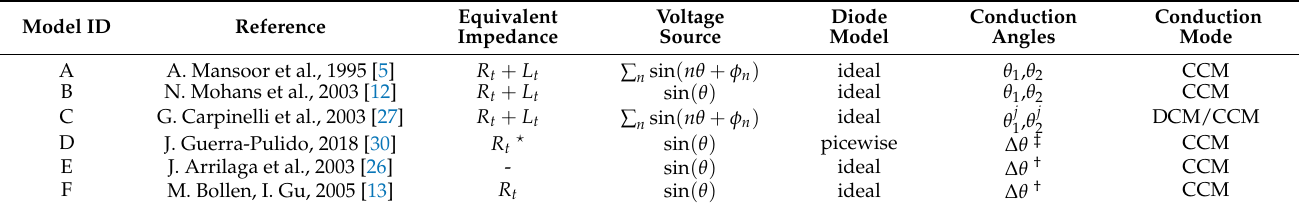
Table 1. Main characteristics of the different models for harmonic analysis of single-phase diode bridge